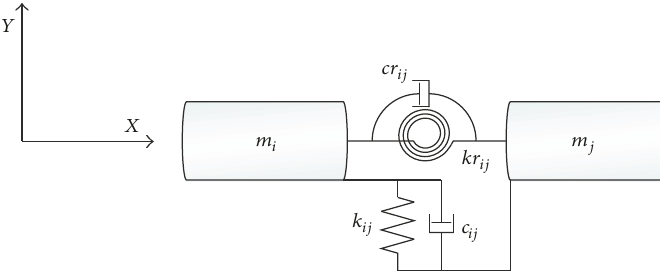
Figure 1: The simplified rotational and translational mechanical joint used to represent the interphalangeal joints of the finger.